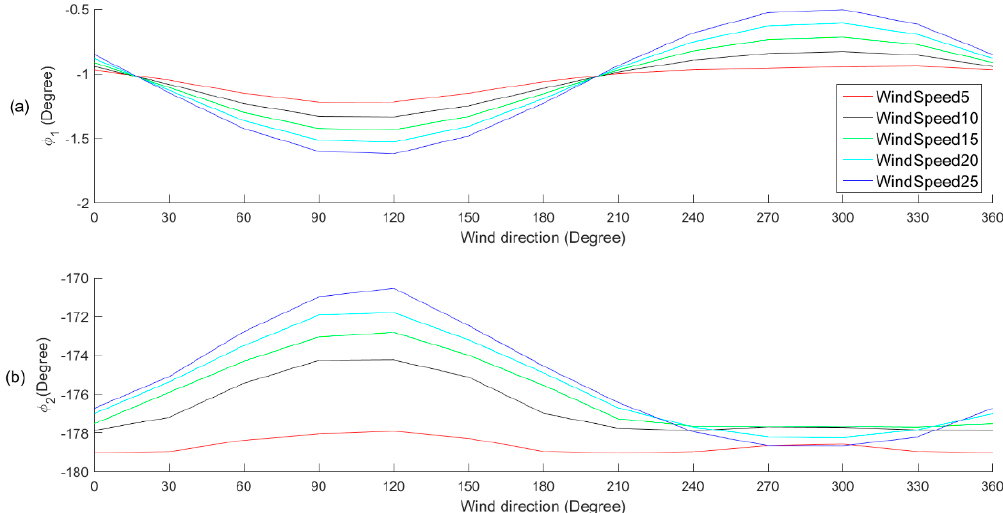
Figure 7. The influence of wind speed on the relation between wind direction and the angles of ( a ) ϕ 1 and ( b ) ϕ 2 . The elevation and azimuth of the receiver are 75 ◦ and 108 ◦